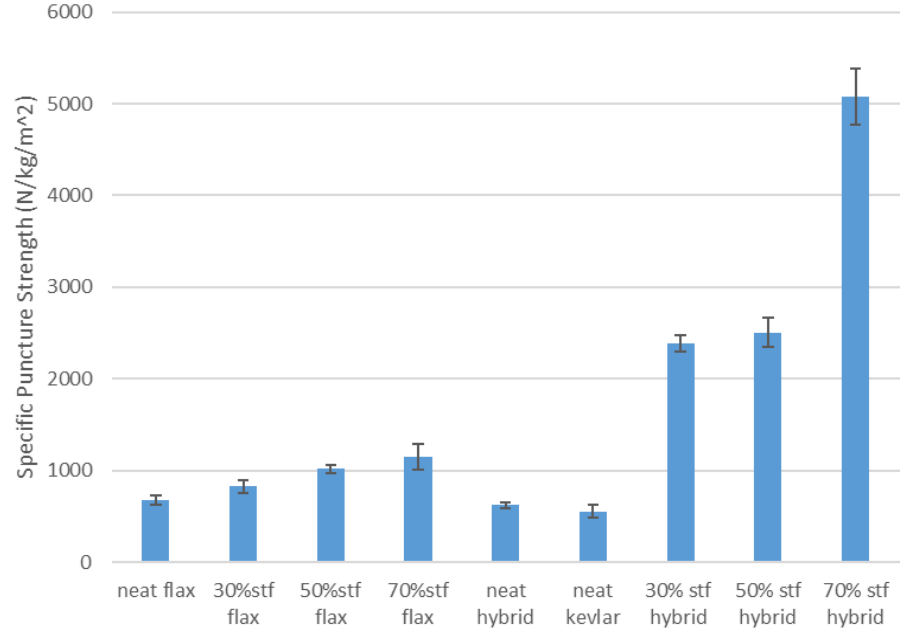
Figure 7. Comparison of specific puncture strengths.